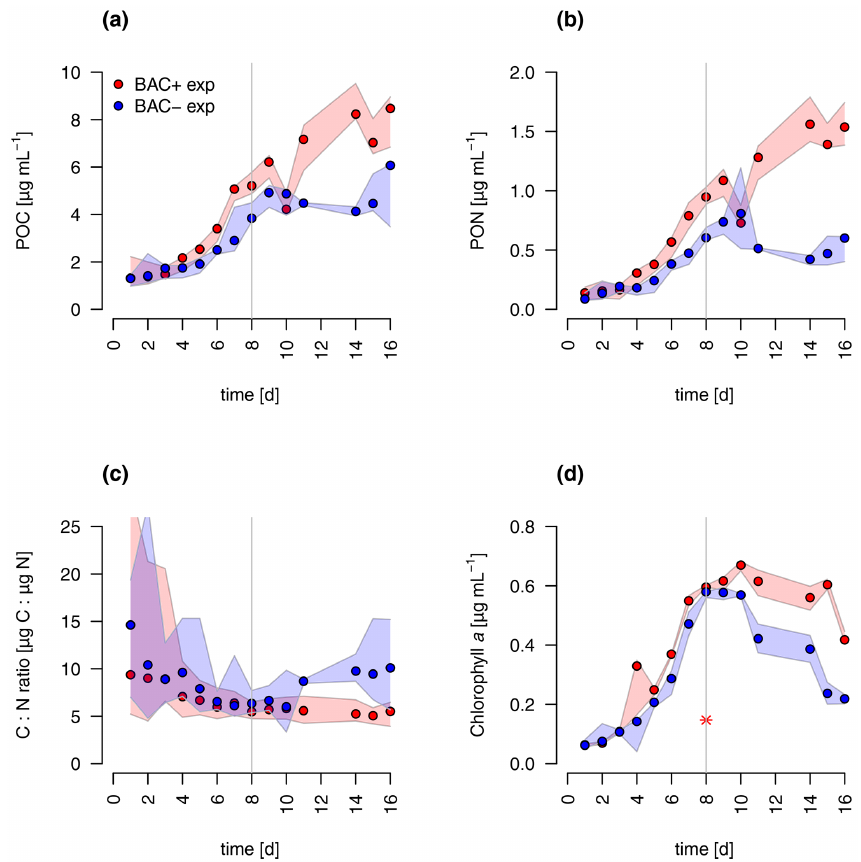
Figure 4. Total particulate organic (a) carbon (POC) (b) nitrogen (PON), (c) C:N ratios, and (d) chlorophyll a concentration in experimental cultures (the asterisk indicates a presumed measurement error). Blue symbols are BAC − cultures and red show BAC + cultures. Circles show median values (blue = BAC − , red = BAC + ) and the colored polygons show the maximum and minimum of measured data ( n = 2–3, Table S2). The grey line indicates the start of the stationary